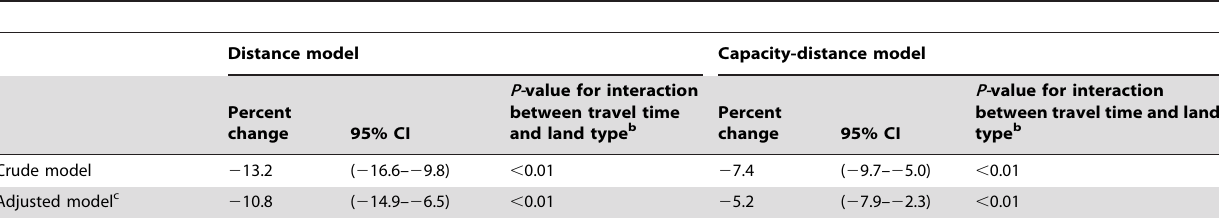
Table 2. Percent change in age- and sex-adjusted standard prevalence rate (SPR) a ratio for dialysis patients per 10-min increase in travel time to the nearest dialysis facility (census block n =1,867).